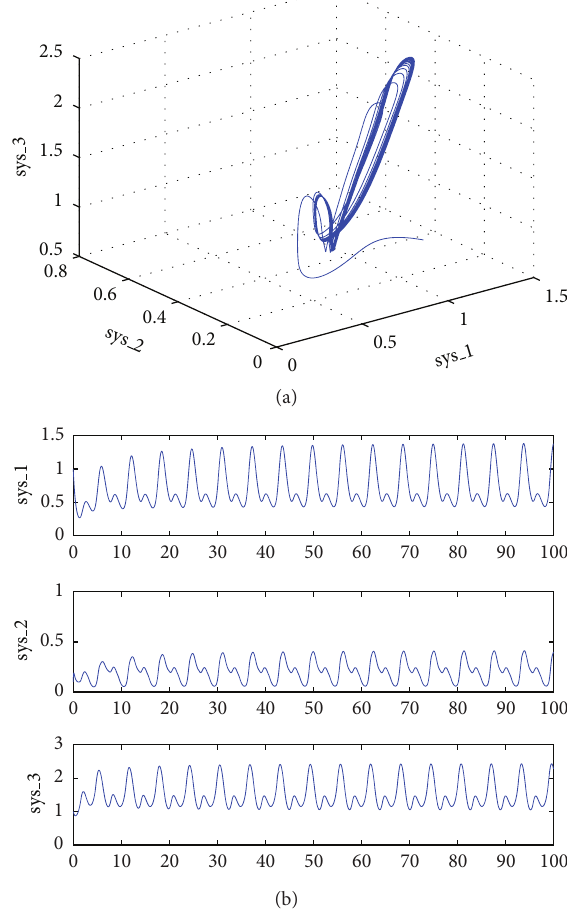
Figure 17: Stochastic system with a white noise 𝑢 𝑖𝑖 = 0.001 , 𝑖 = 1, 2,3 .